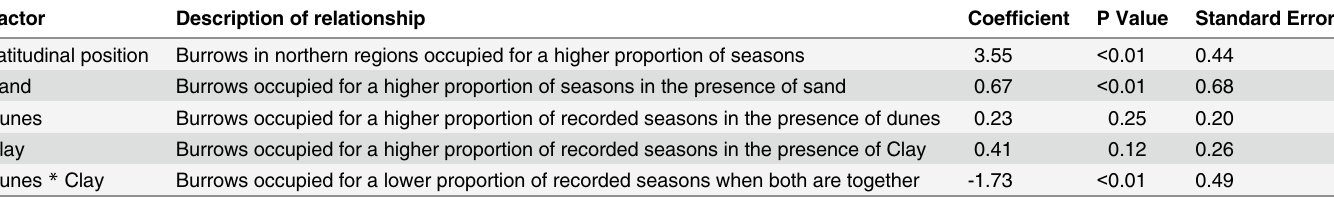
Table 4. Description of terms in the parsimonious model of multiple season occupancy